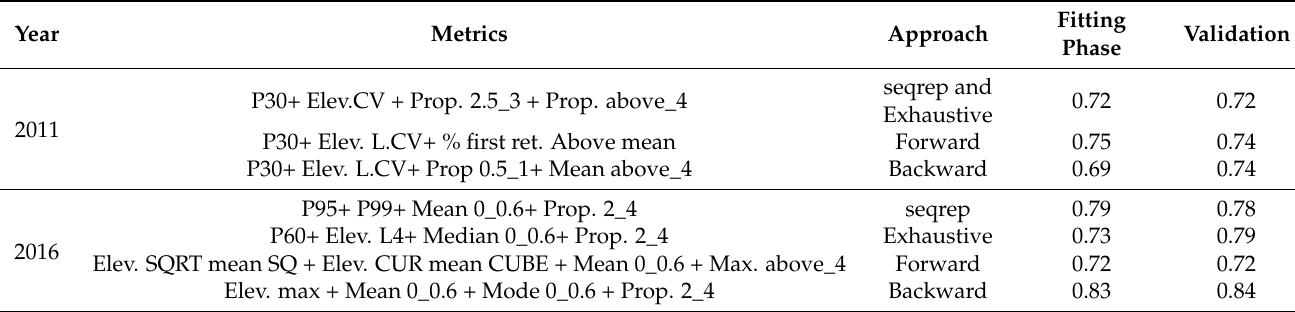
Table 9. Overall accuracy of all subsect selection selected metrics using SVMr classification method. seqrep stands for sequential